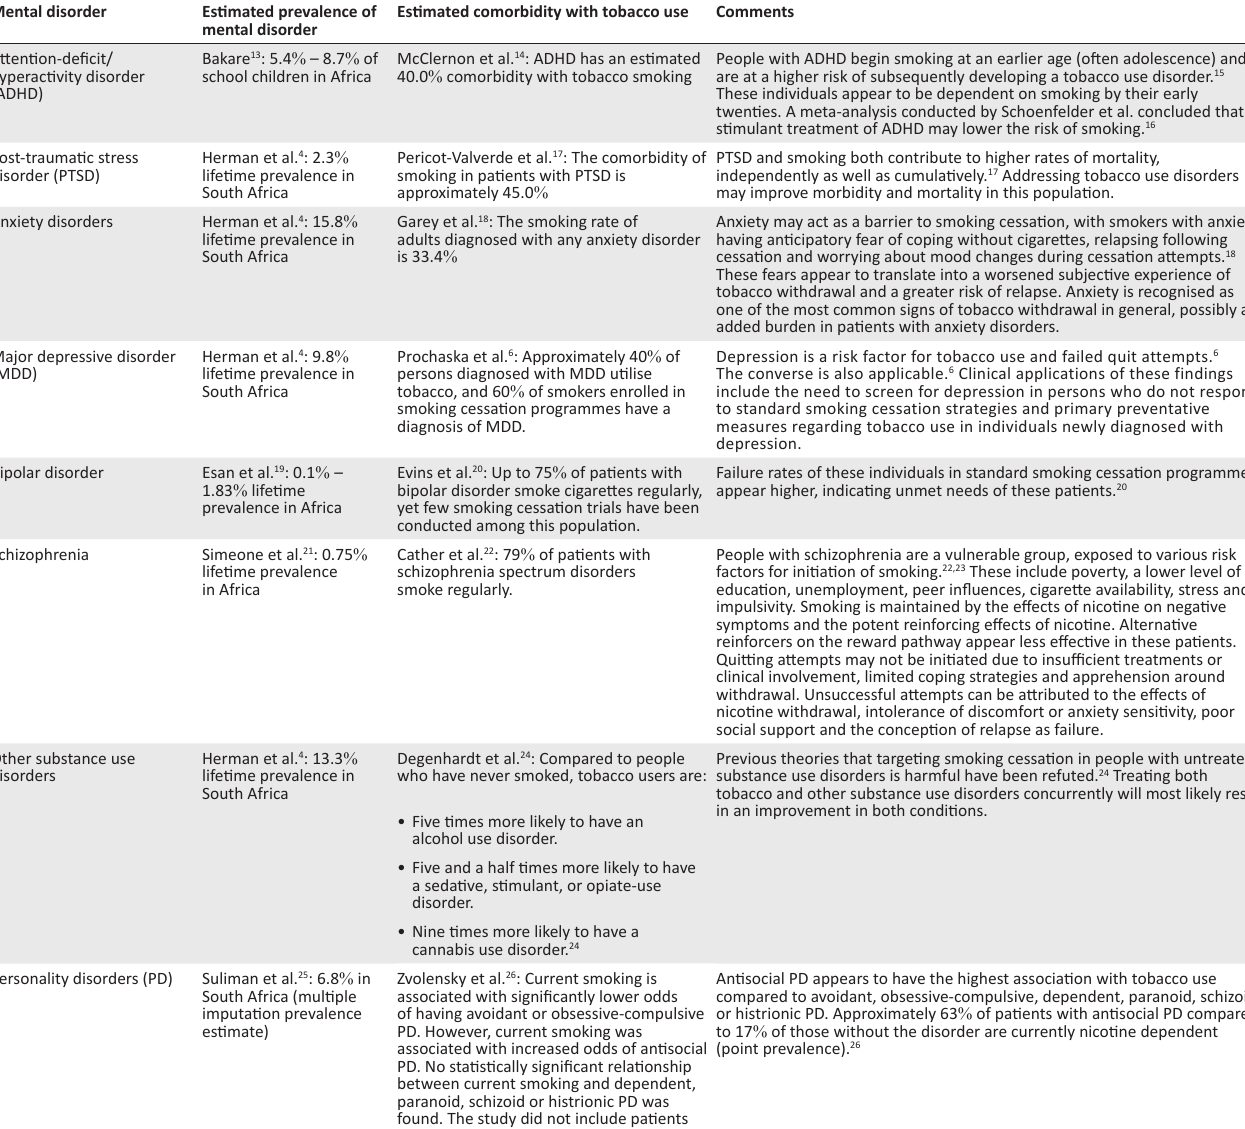
TABLE 1: Prevalence of mental disorders and tobacco use among people with mental